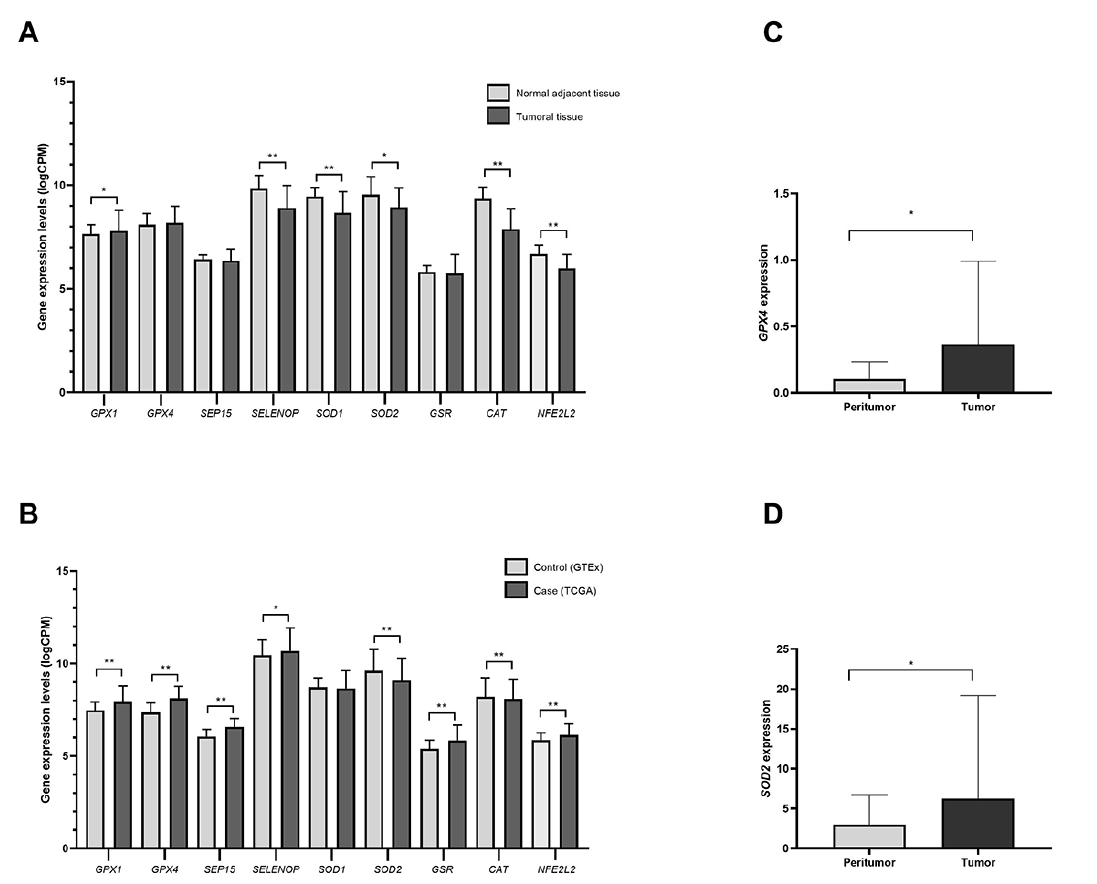
Figure 1 – Gene expression profiles. (A) Gene expression levels in the TCGA-LIHC dataset for tumoral and normal adjacent tissues. (B) Gene expression levels in case (TCGA) versus control (GTEx) analysis. (C) and (D) Significant differentially expressed genes in ISCMPA’s sample (tumoral versus peritumoral tissues). *p<0.05,